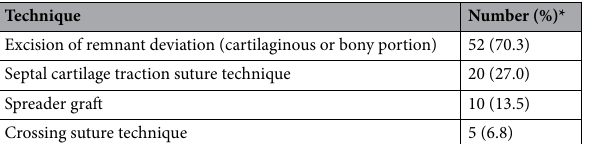
Technique Number (%)* Excision of remnant deviation (cartilaginous or bony